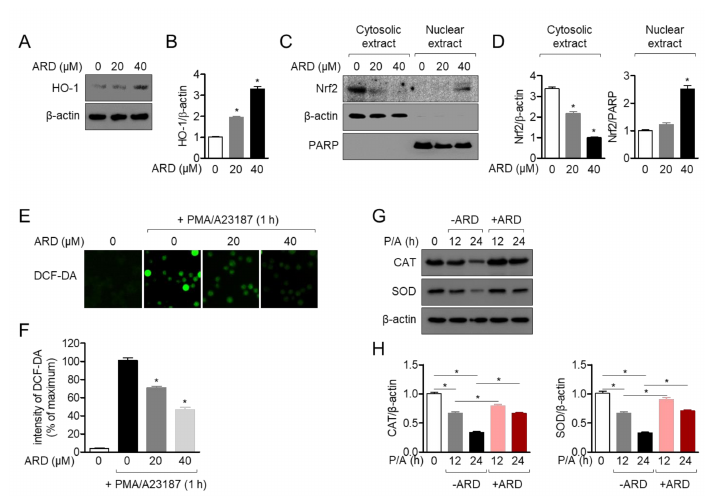
Figure 8. Aromadendrin induces the Nrf2 pathway and acts as an antioxidant in activated T cells. ( A ) The expression of HO-1 was detected by Western blot in Jurkat T cells treated with 20 or 40 µ M of aromadendrin for 24 h. ( C ) The expression of Nrf2 in the cytosol and nucleus was determined by Western blot in Jurkat T cells treated with 20 or 40 µ M of aromadendrin for 2 h. To separate nuclear extracts from whole lysate, a PE-NER kit was used. ( E ) Generated ROS (reactive oxygen species) was measured by 10 µ M DCF-DA staining in Jurkat T cells pre-treated with 20 or 40 µ M of aromadendrin for 24 h and treated with PMA (100 nM) / A23187 (1 µ M) for 1 h. ( G ) Jurkat cells pre-treated with 40 µ M aromadendrin for 24 h was stimulated with PMA (100 nM) / A23187 (1 µ M) for 12 h or 24 h. After stimulation, cells were harvested, and the expression of catalase (CAT) and superoxide dismutase (SOD) was detected by Western blot. ( B , D , F , H ) The mean values ± SEM are presented in the bar graph. * p < 0.05, versus the control cells ( A , C , E ) or indicated two groups